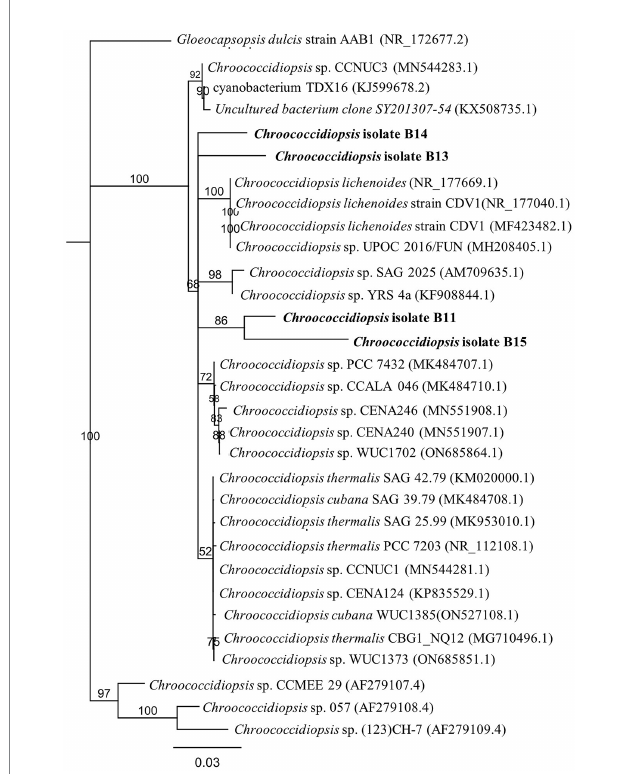
FIGURE 1 Phylogenetic tree inferred from 16S rRNA gene sequences from the Chroococcidiopsis isolates from the solar panel samples. The tree was constructed using the neighbor-joining method in MEGA-X. The length of the scale bar indicates 0.2 substitutions per site. The percentages of bootstrap support of branches (>50%) are indicated at each node. The isolates from the solar panel are shown in